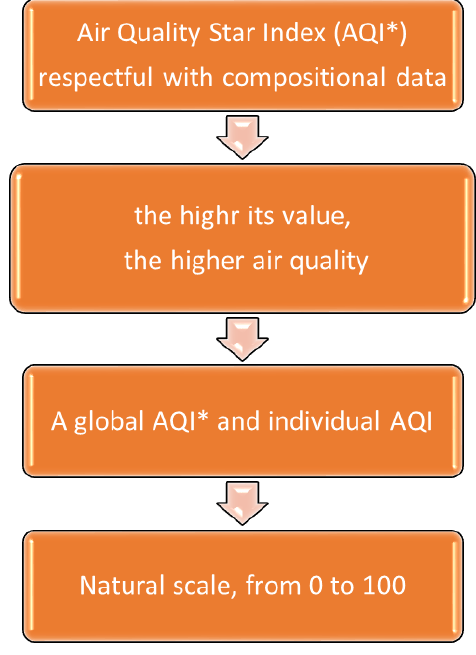
Figure 1. Improvements Air Quality